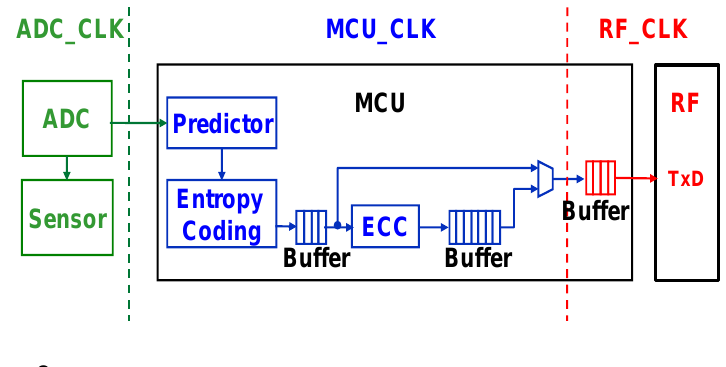
Figure 5. Three clock domains of the wireless body sensor node.